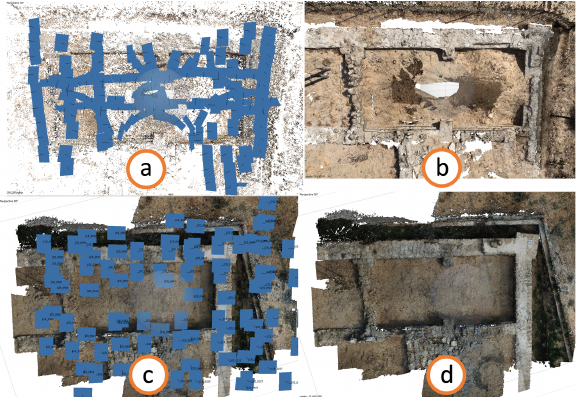
Figure 2 . a): organization of shots from the ground and, b): point cloud in 2012, c): organization of drone shots and, d): point cloud in 2021